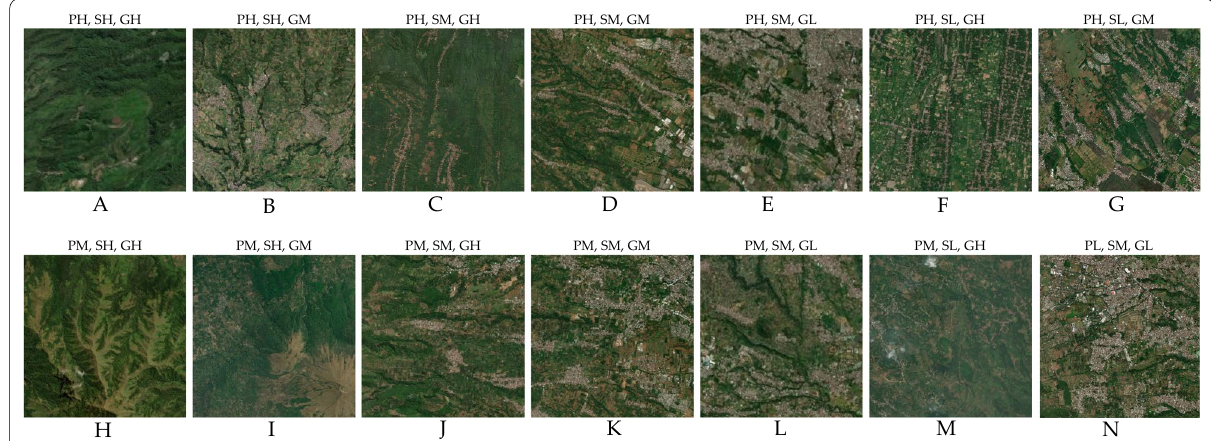
Fig. 11 Varying combination of precipitation (P), Slope (S), and GVF (G) resulting in high runoff classes (0–33rd percentile) in the study area, with H means high percentile (0–33rd), L is low percentile (67–100th) and M is medium percentile (34–66th). High runoff prone areas represent roughly